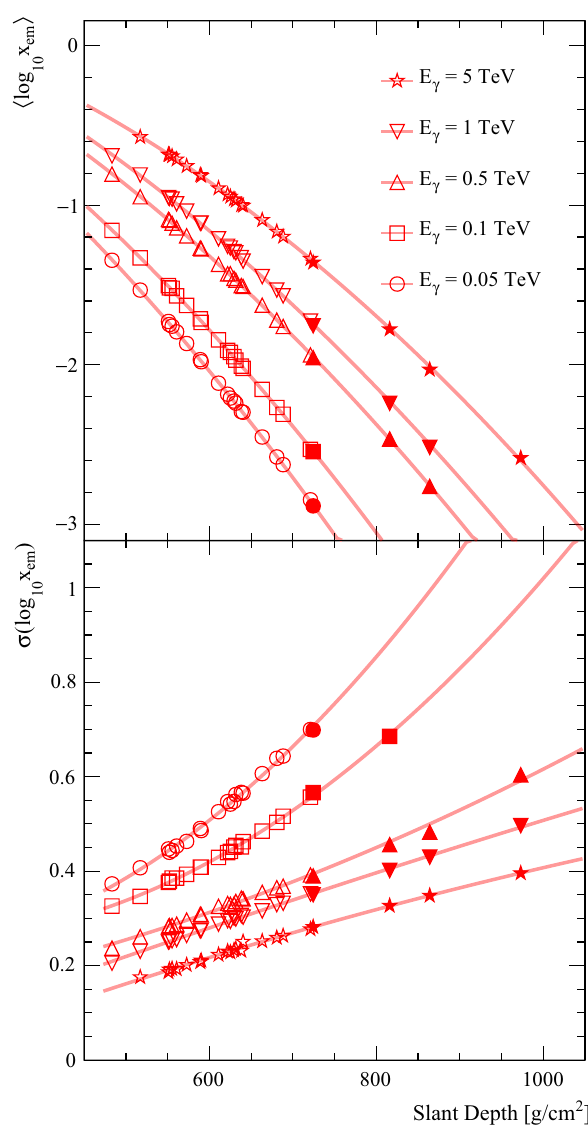
Fig. 5 Dependence of fractional electromagnetic energy arriving at ground x em = E em / E γ on slant depth, for primary γ -rays of differ- ent energies. The top panel shows the dependence of the mean of the log 10 ( x em ) distribution, while the bottom panel shows the behaviour of the rms ( σ ) of the same distribution. Each data point corresponds to the slant depth of a combination of zenith angle and ground-level from Fig. 14, filled markers correspond to simulation sets that have a zenith angle larger than 30 ◦ . Statistical uncertainties are of similar size as the markers or smaller